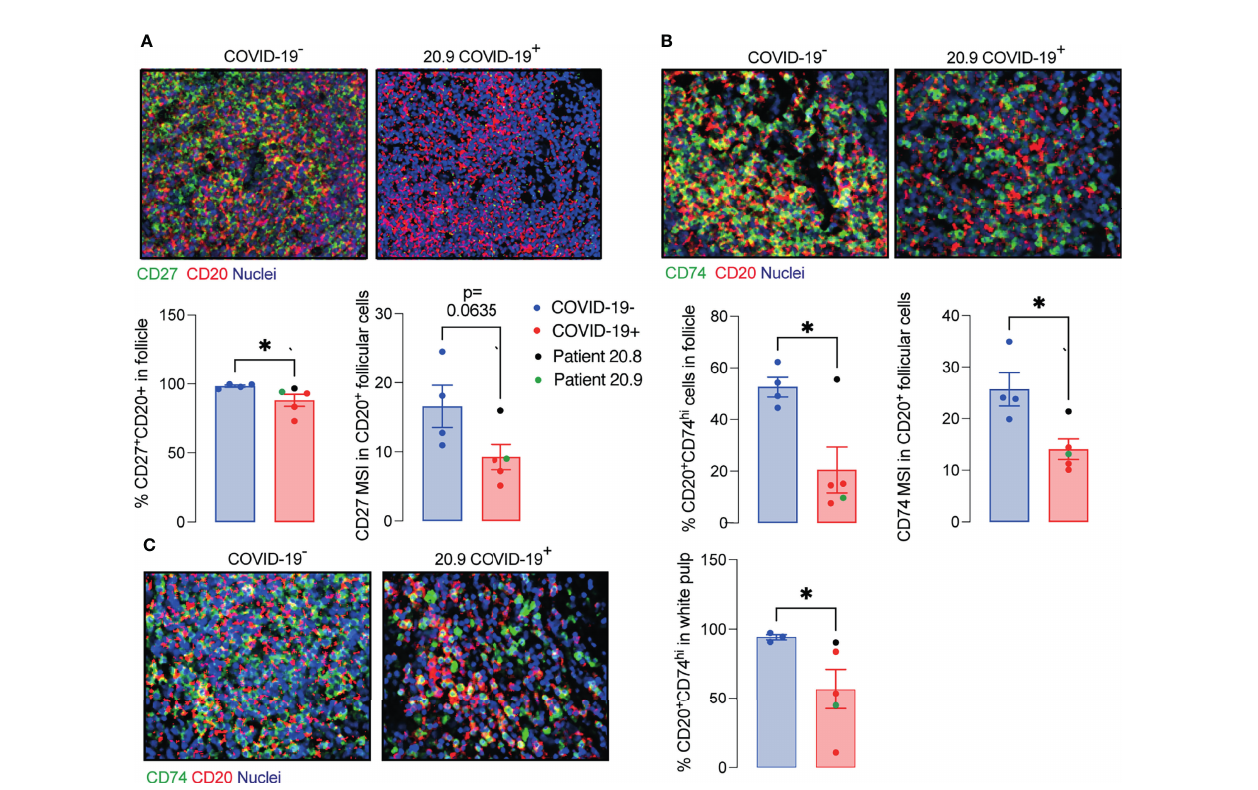
FIGURE 5 | Decreased memory and antigen-presenting B cells in ileal follicles in Peyer ’ s patches (PP) of COVID-19 patients. (A) Representative images from histoCAT showing CD27 (green) and CD20 (red) in ileal follicles in Peyer ’ s Patch (PP) from COVID-19 - and COVID-19 + patients on the top. The percentage of CD27 + CD20 + cells and mean signal of CD27 in B cells on the bottom. (B) Representative images from histoCAT showing CD74 (green) and CD20 (red) in ileal follicles on the top. The percentage of CD74 hi CD20 + cells and mean signal of CD74 in B cells on the bottom. (C) Representative images from histoCAT showing CD74 (green) and CD20 (red) in white pulp from spleen on the left. The percentages of CD74 hi CD20 + cells and mean signal of CD74 in B cells on the right. Two tailed Mann-Whitney t test. *P <